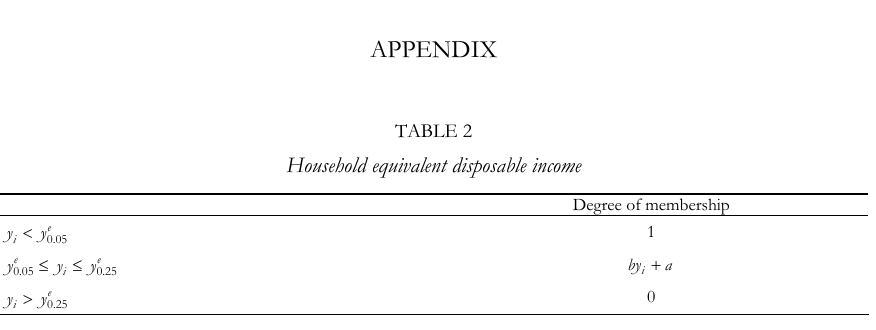
Gender, age and occupational status of the household head